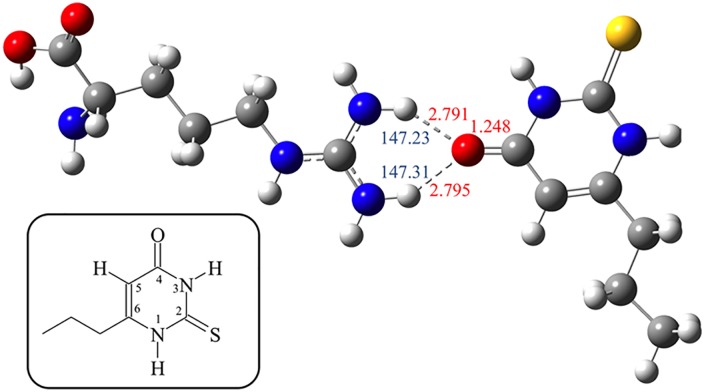
DFT Optimized structure of H-bonded adduct between PROP (right) and ArgH+ (left) calculated in water.Selected relevant interatomic distances are shown in red ink. N—H···O angles are shown in blue ink. Oxygen atoms are depicted in red, nitrogen atoms in blue, the sulfur atom in yellow, carbon in grey, and hydrogens in white. In the insert: atom numbering scheme of the heterocyclic skeleton in PROP.